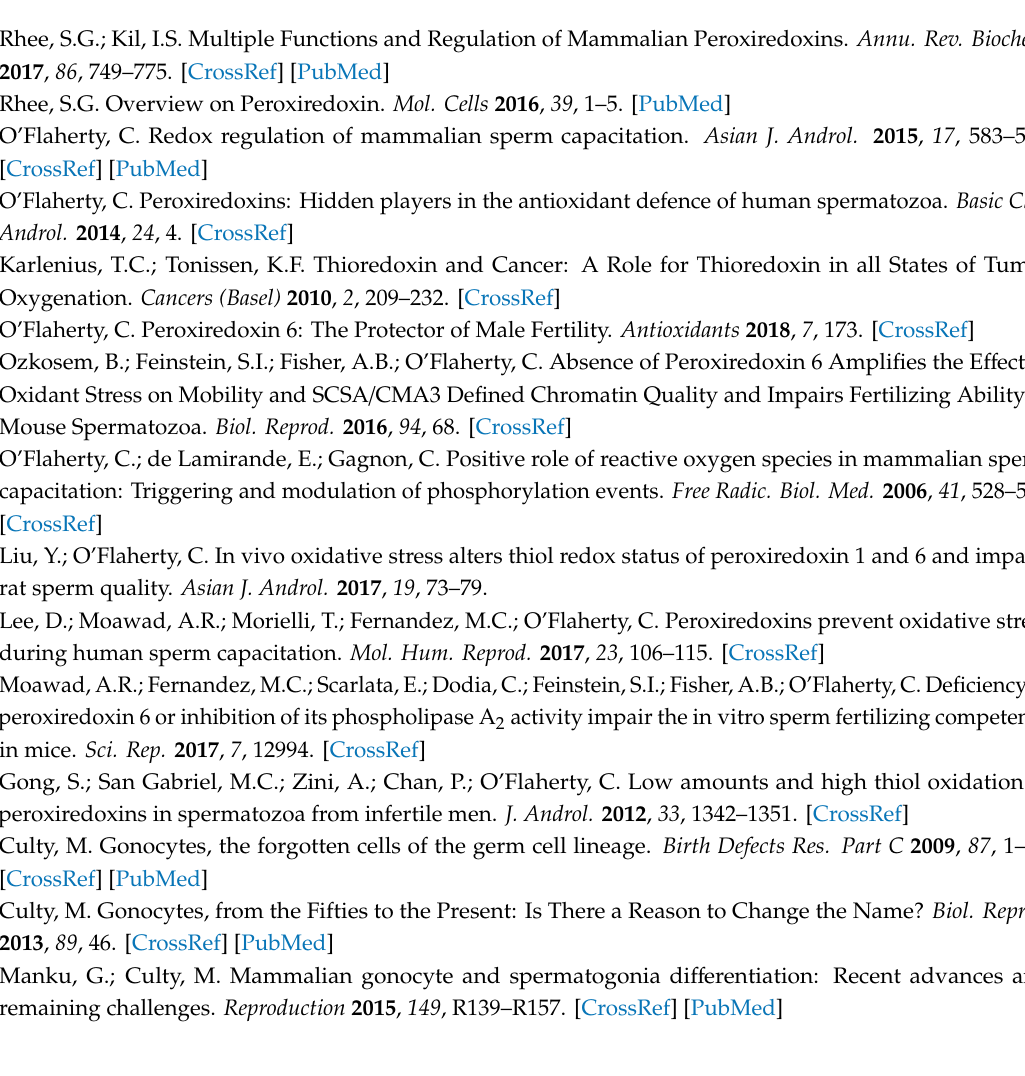
Table S1: Relative gene expression of antioxidant genes expressed in rat PND3 gonocytes and PND8 spermatogonia. The results represent the mean ± SEM of 3 independent RNA samples for each age, each made from cells isolated in multiple animals. There was no significant di ff erence between the two types of germ cells for any of the genes. A few genes presenting a signal intensity below 20 were not